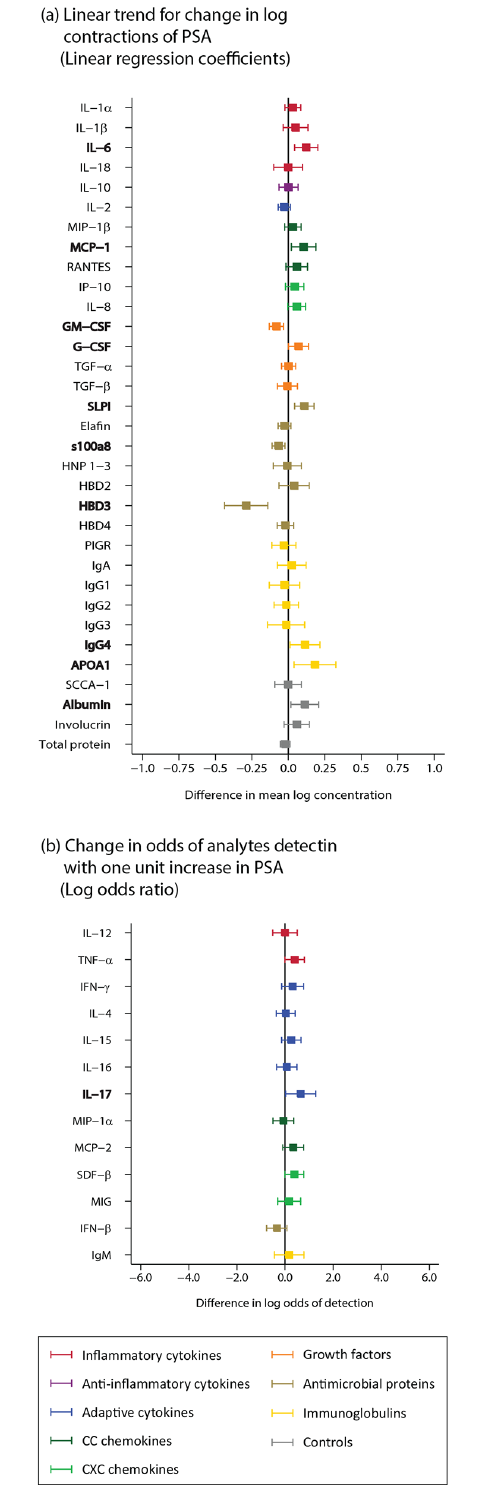
Fig 4. Prostate-specific antigen (PSA, n = 370). PSA categories: None, low positive ( < 4 ng/mL), high positive ( (cid:3) 4 ng/mL). Bolded analytes represent associations with a p-value (cid:1) 0.05. (A) Analytes with (cid:3) 85% detection using linear regression, linear trend for change in log concentration. (B) Analytes with < 85% detection using logistic regression, change in odds of analyte detection (if < 85% LLOQ) with one unit increase in exposure